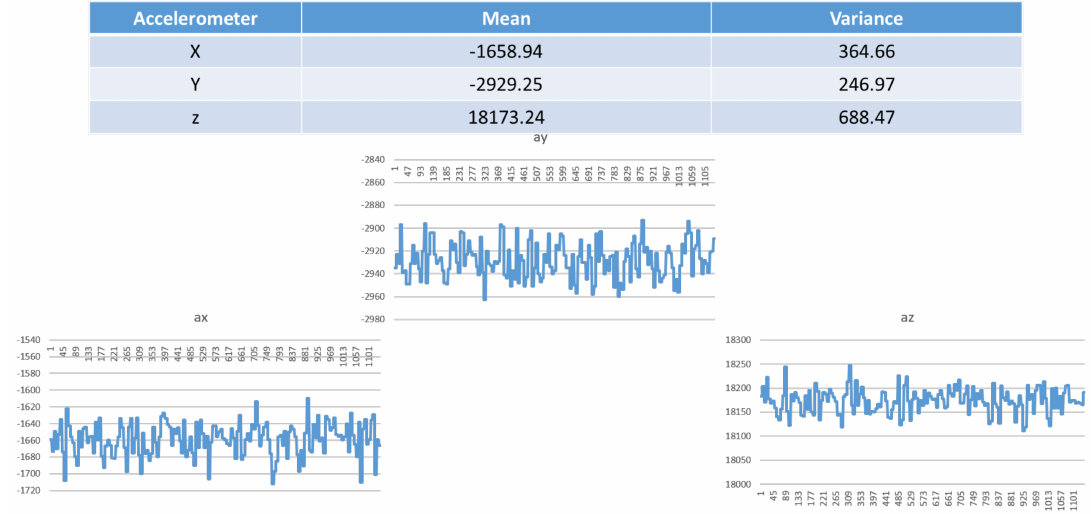
Figure 6. Mean and variance of the accelerometer in the x, y and z